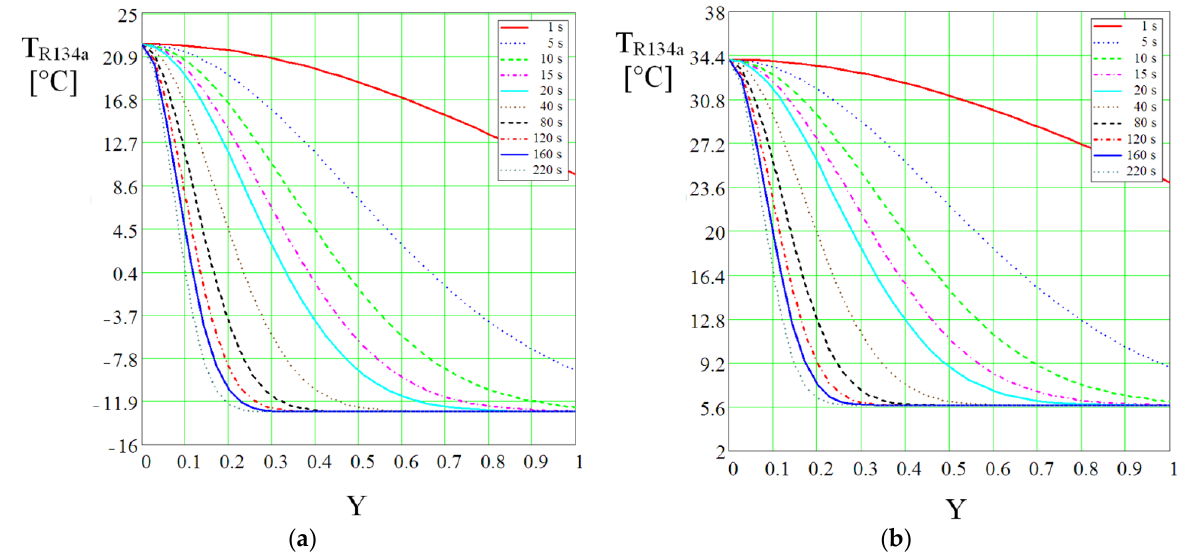
Figure 14. Temperature change in non-stationary mode for R134a coolant along the rectangular microchannels of the vaporizer at compressor speed of 4400 rpm: ( a ) without hot source, ( b ) with hot source at T = 34 °C.